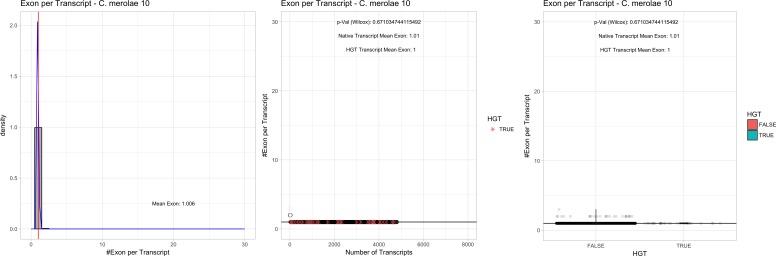
Exon/Intron – Cyanidioschyzon merolae 074W: (Left) Mid) Cumulative %GC distribution of transcripts.Red line shows the average, blue line a normal distribution based on the average value. The data is categorical (genes have either one, two, three etc. exons) and does not follow a normal distribution. (Mid) Ranking all transcripts based upon their number of exons. Red ‘*' demarks HGT candidates. As the number of exons was not normally distributed, transcripts were ranked by number of exons. In order to resolve the high number of tied ranks (e.g. many transcripts have two exons) a bootstrap was implied by which the rank of transcripts sharing the same number of exons was randomly assigned 1000 times. Wilcoxon-Mann-Whitney-Test applied for the determination of significant rank differences between the native gene and the HGT candidate subset. (Right) Violin plot showing the number of exons per transcript distribution across native transcripts and HGT candidates.